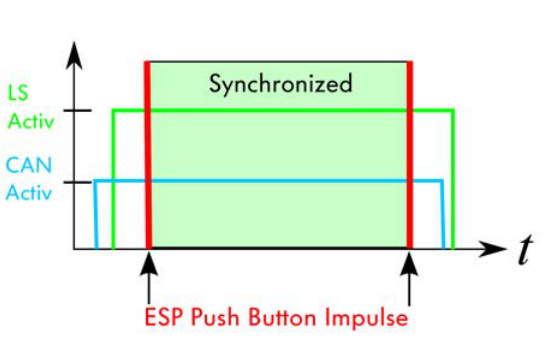
Figure 5. Time diagram showing the activity times of the laser scan device (LS) and the field bus system (here: CAN-Bus), as well as the synchronized period with the ESP